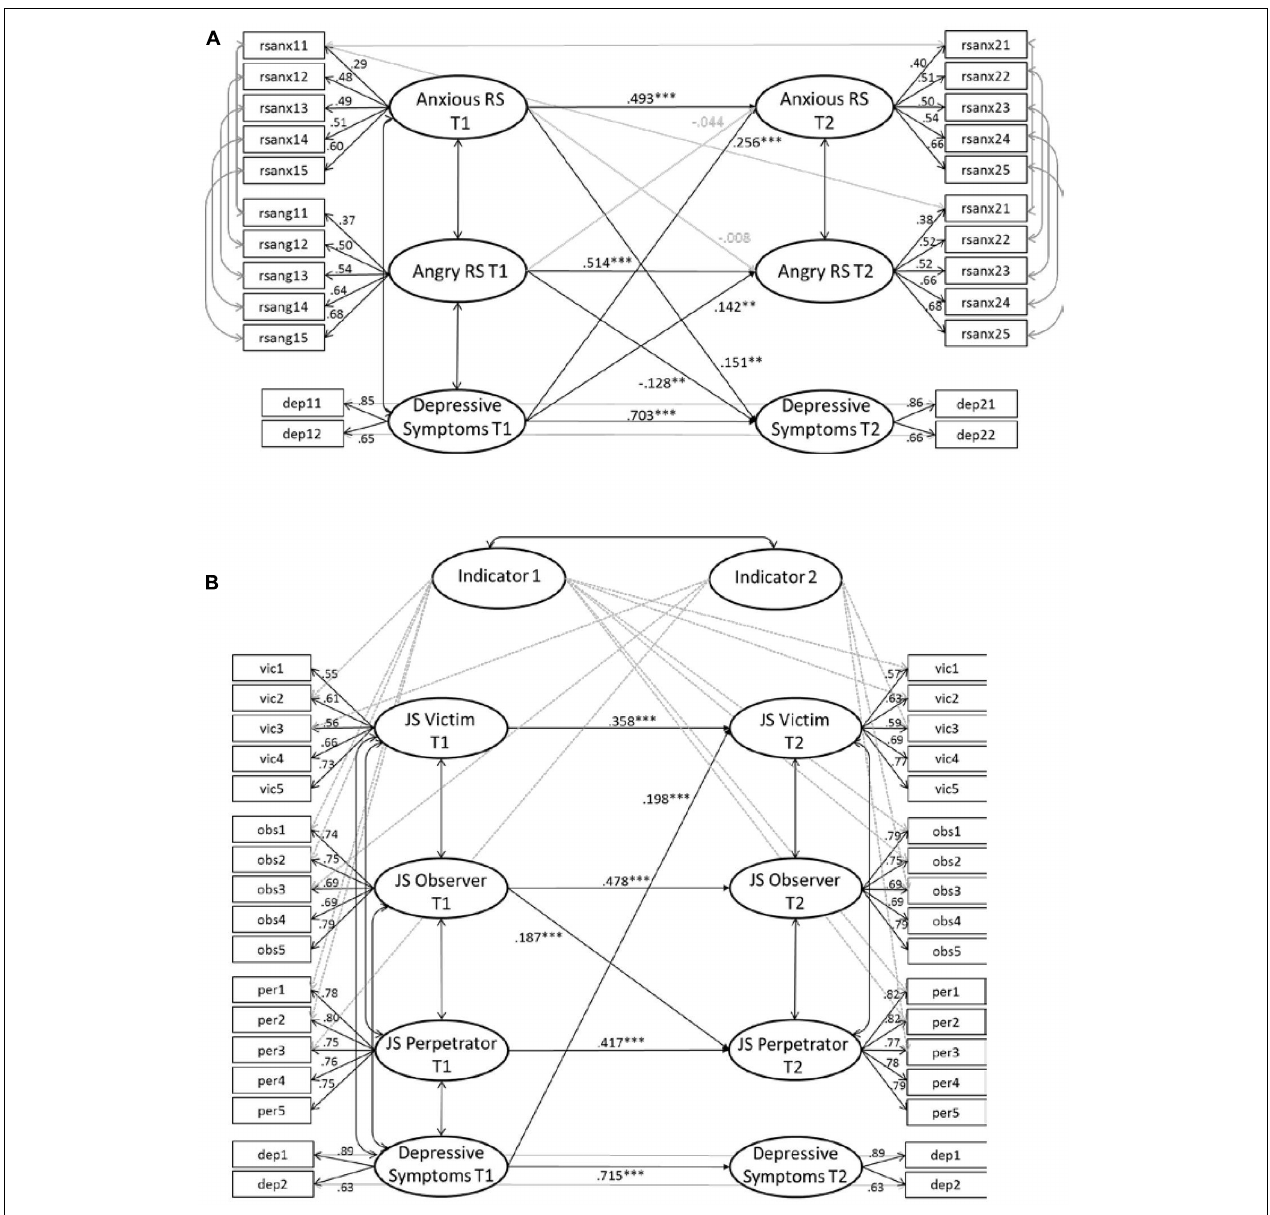
FIGURE 1 | Cross-lagged models with RS (A) , JS (B) , and depressive symptoms assuming strong measurement invariance. RS: Error terms of the accordant items allowed to correlate (example displayed). JS: Error terms of the remaining two items of the JS subscales allowed to correlate (not displayed). Significant pathways and standardized model results